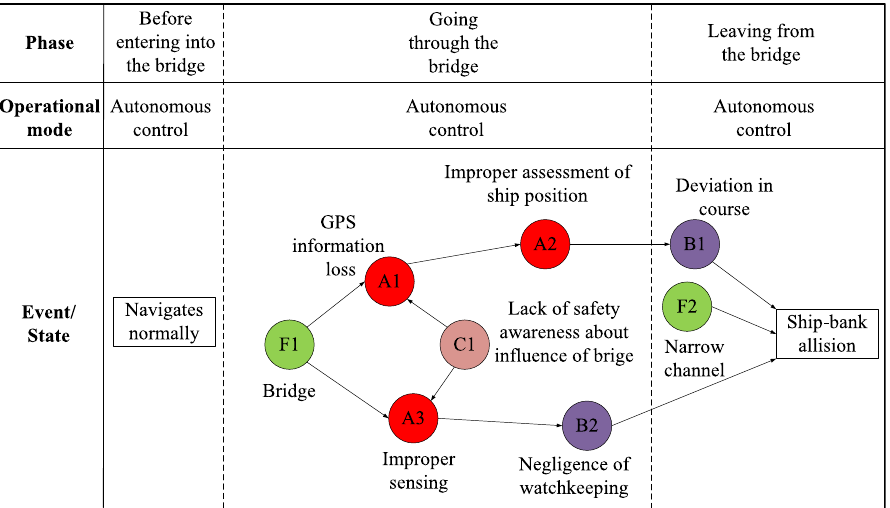
Figure 2. Accident paths of model MASS in autonomous control.